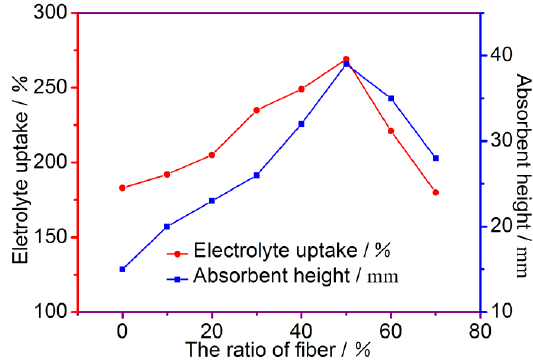
Figure 4. The effect of fiber ratio on electrolyte uptake.